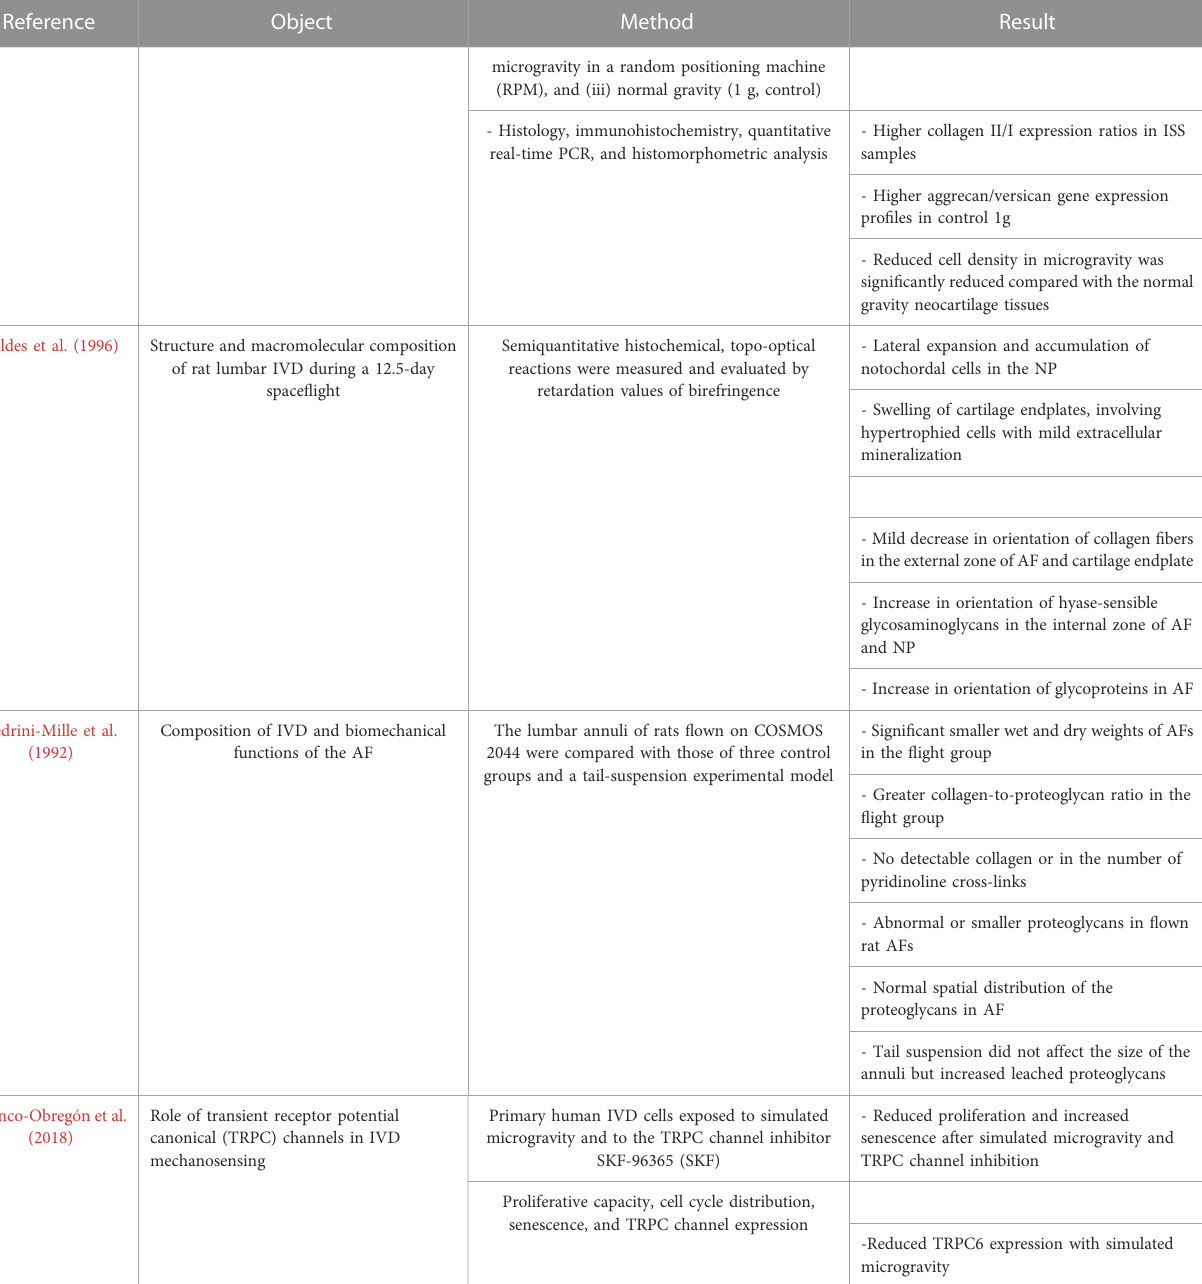
TABLE 1 ( Continued ) Summary of selected articles addressing research on the effects of simulated microgravity on the intervertebral